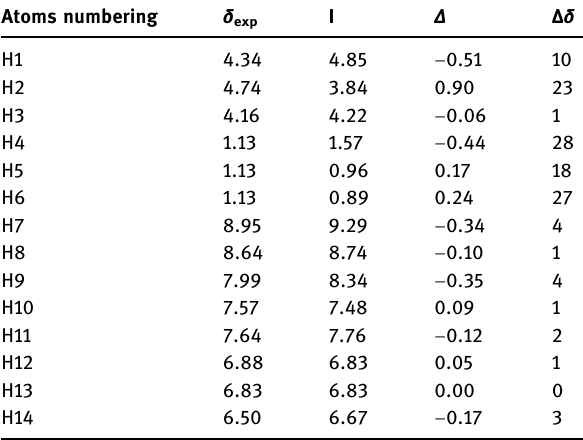
Table 8: Experimental ( δ exp ) and calculated chemical shifts ( I ) for compound 1